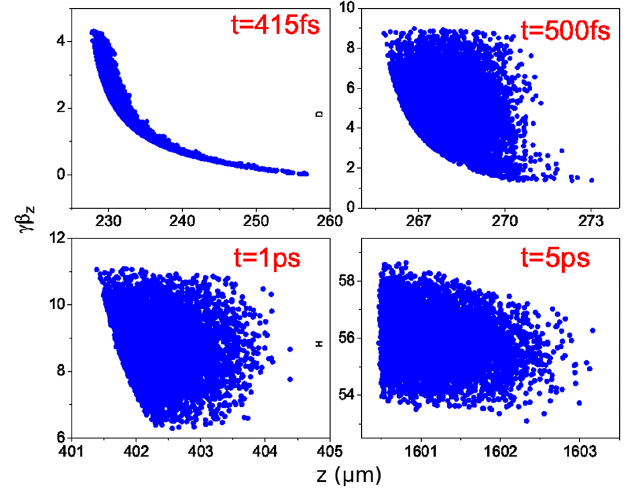
FIG. 6. Snapshots of beam longitudinal phase space at t ¼ 415 , 500, 1, 5 ps. The first figure corresponds to the moment when the ionization is completed.